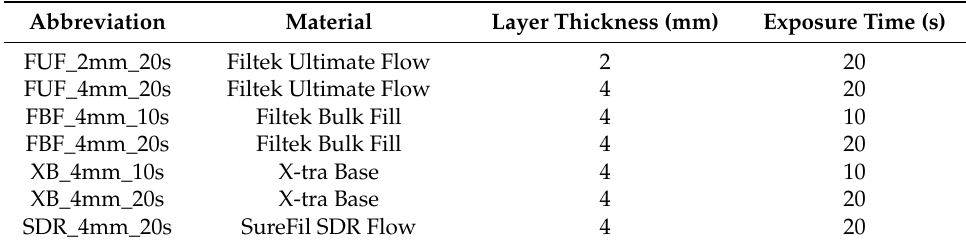
Table 2. Sample preparation with layer thickness and exposure